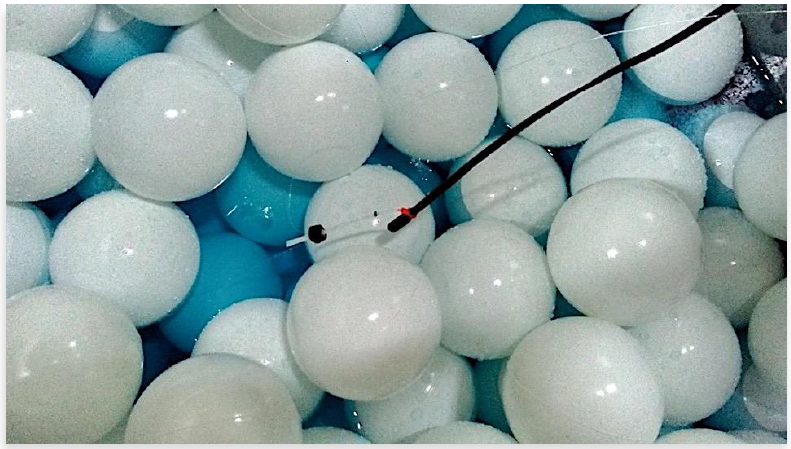
Figure 1. The inside of the cold accumulator with a bed of spherical capsules.